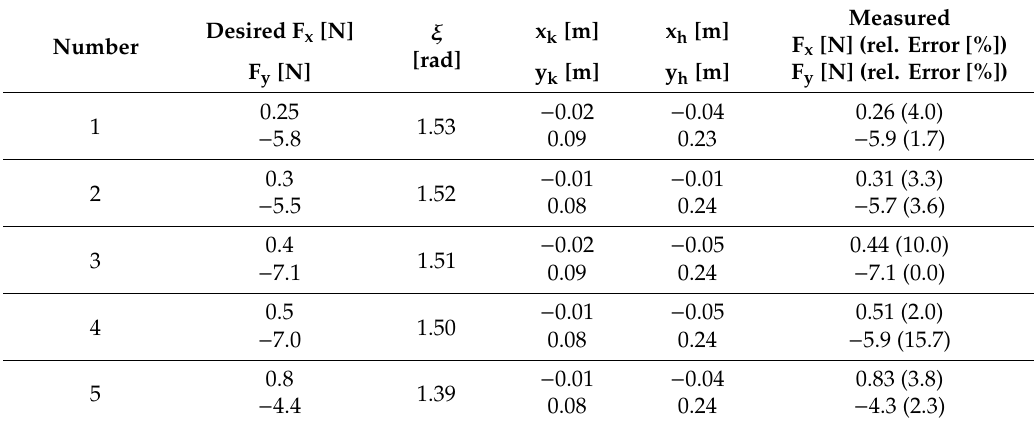
Table 3. Pulley position that provides desired forces and measured